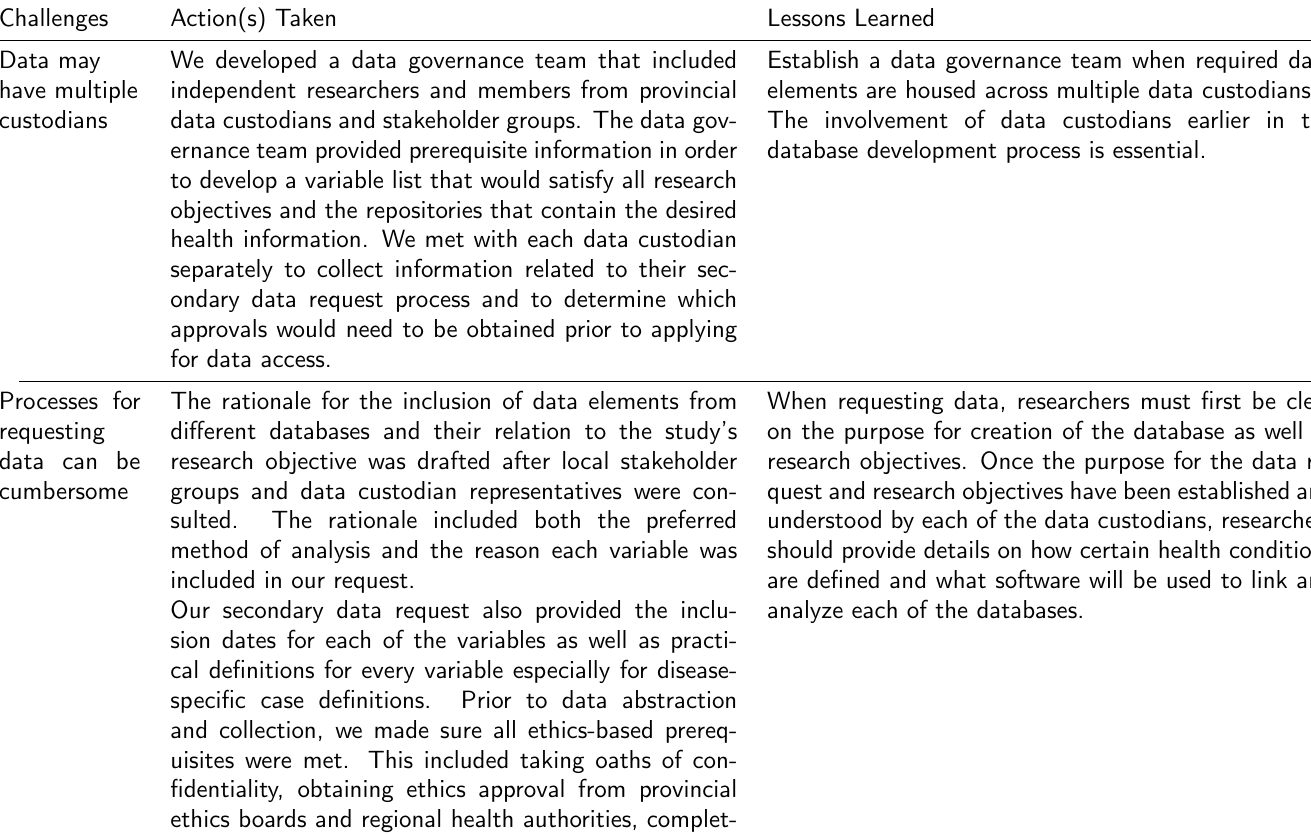
Table 2b: Action(s) taken and lessons learned for challenges that slow the progress of data acquisition.